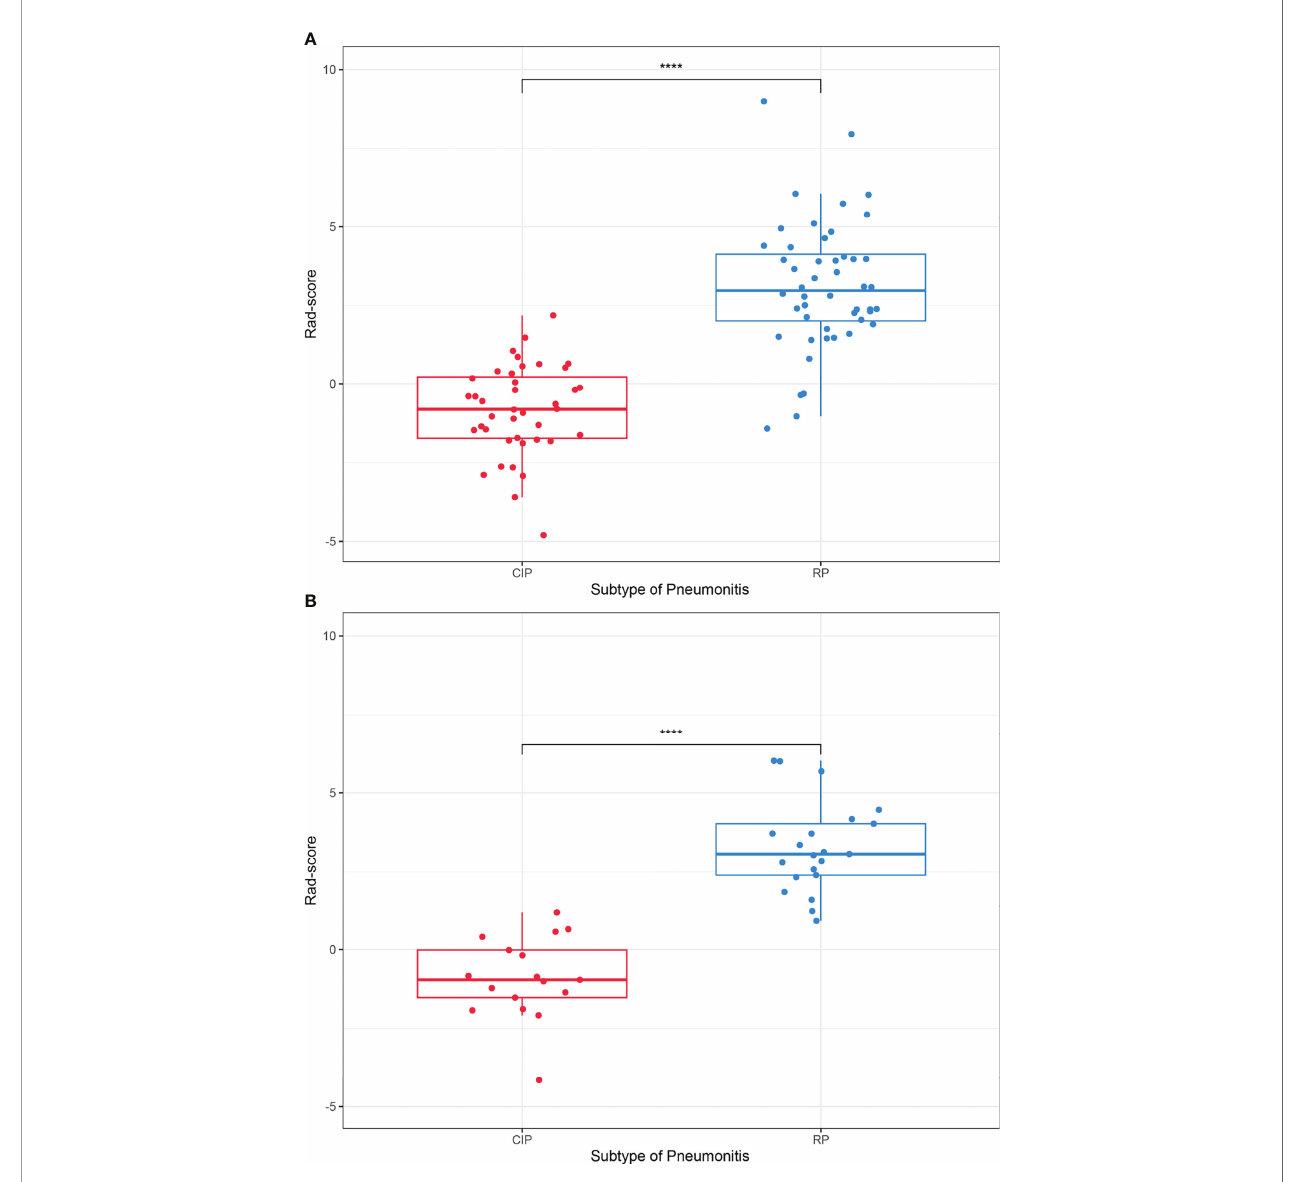
FIGURE 3 | Boxplots for subtypes of lung injury in the (A) training and (B) validation datasets, respectively. **** p -value